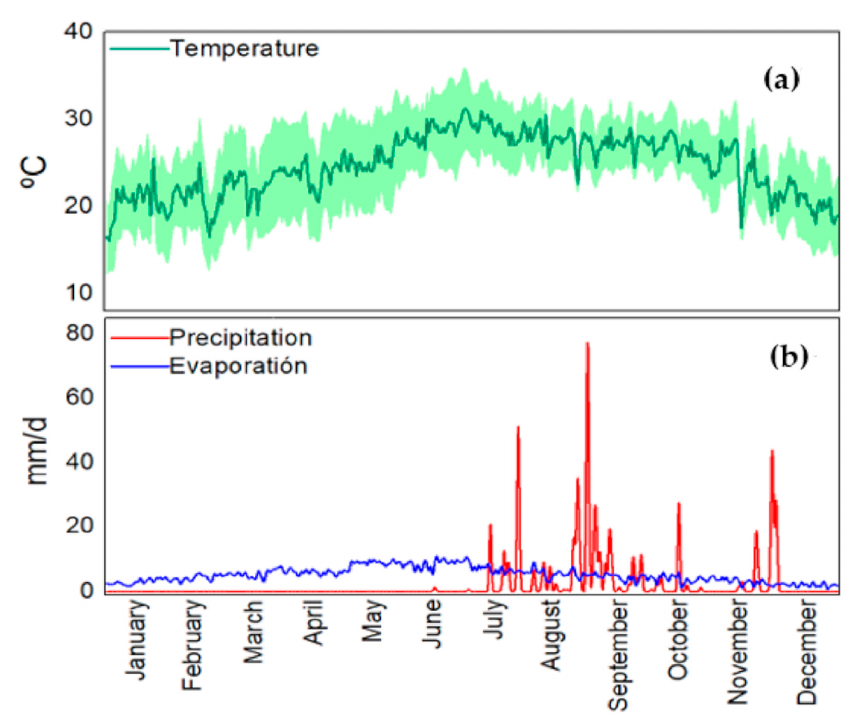
Figure 2. Hydrological and climatological data of the ALM reservoir. ( a ) Air temperature from 2012 to 2019. ( b ) Mean daily precipitation and evaporation from 2012 to